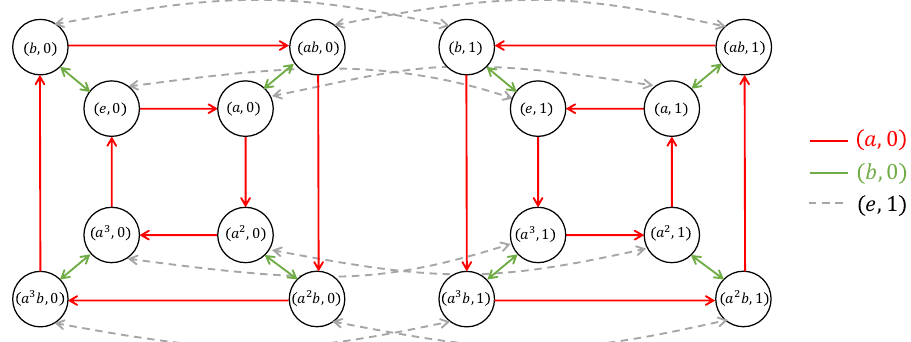
Figure 2. The right Cayley graph RCay ( Dih ( G ) , ˜ S ) , where G is the group with presentation (cid:104) a , b : a 4 = b 2 = e , ab = ba (cid:105) and ˜ S = { ( a ,0 ) , ( b ,0 ) , ( e ,1 ) }